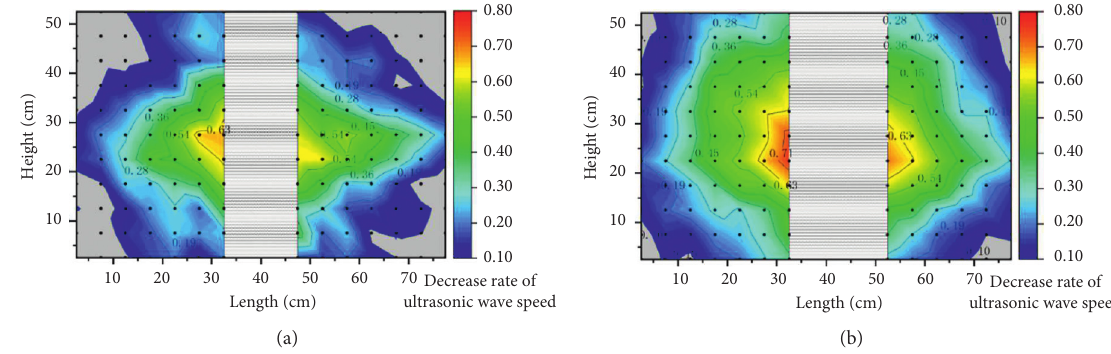
Figure 10: Reduced rate of sonic velocity after blasting: (a) conventional blasting; (b) multidirectional shaped charge